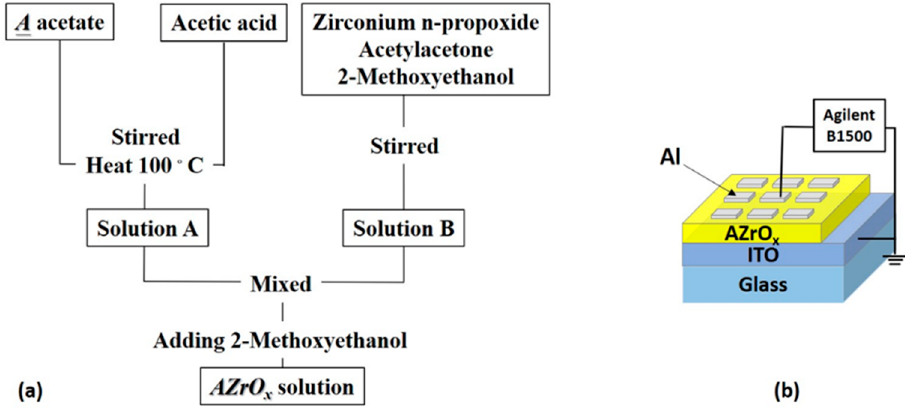
Figure 9. ( a ) Flowchart for the preparation of synthesized AZO x solutions. ( b ) Schematic structure of the Al/AZO x /ITO (A = Sr, Ba, Mg) RRAM.